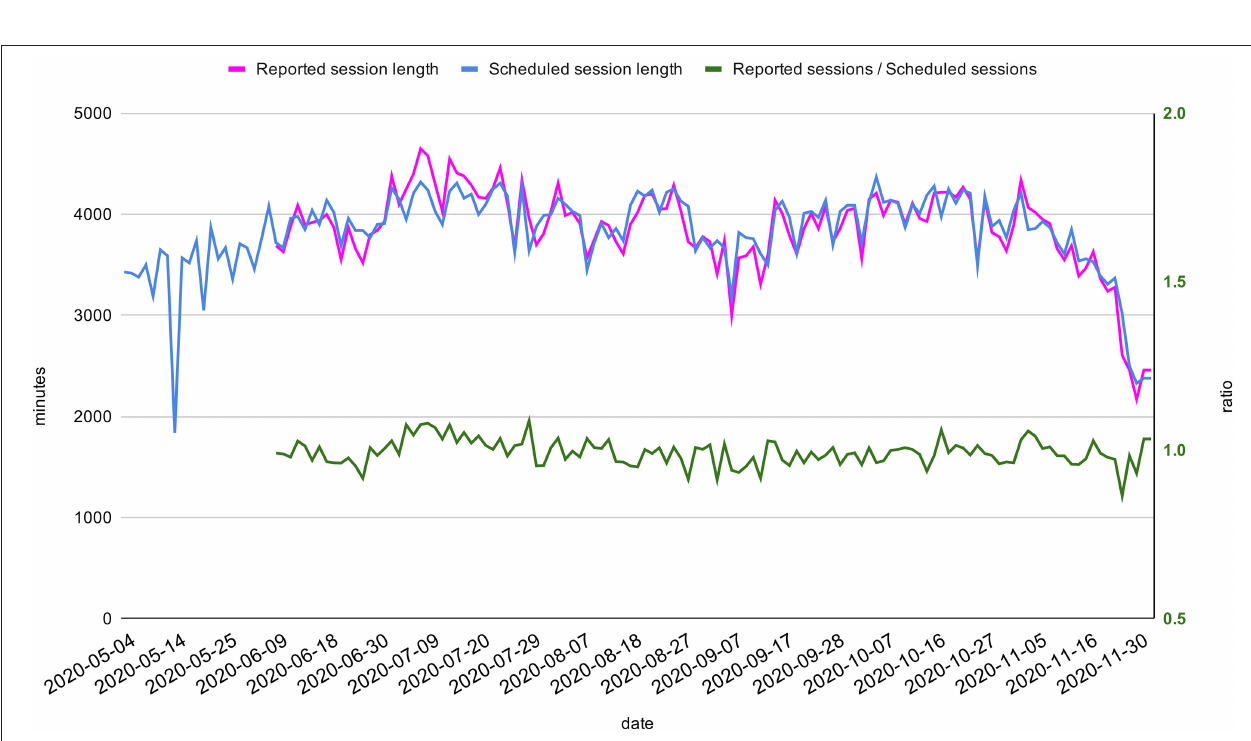
Frontiers in Neurology |